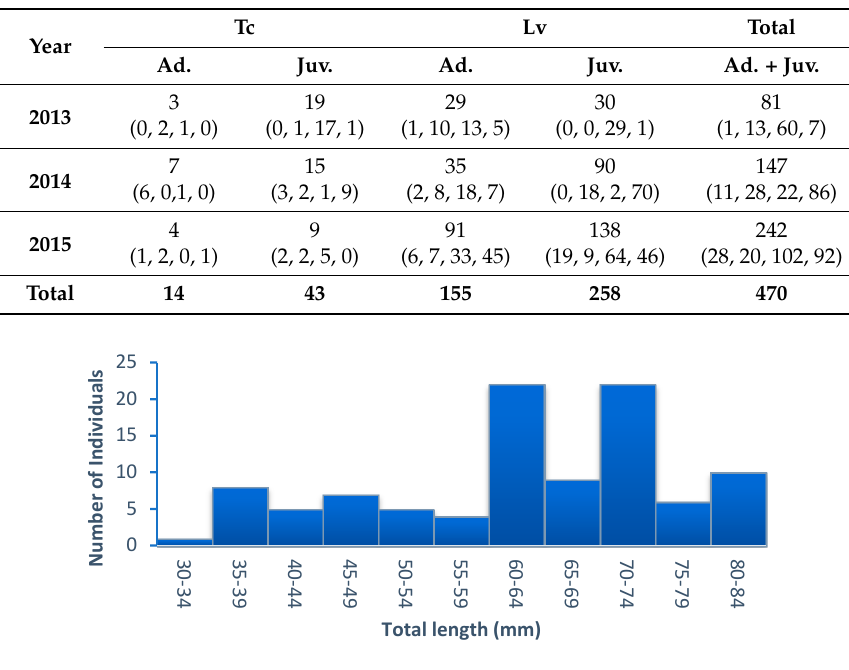
Figure 3. Length distribution of Smooth Newts observed at hotels in 2015 (No. of individuals = 99).